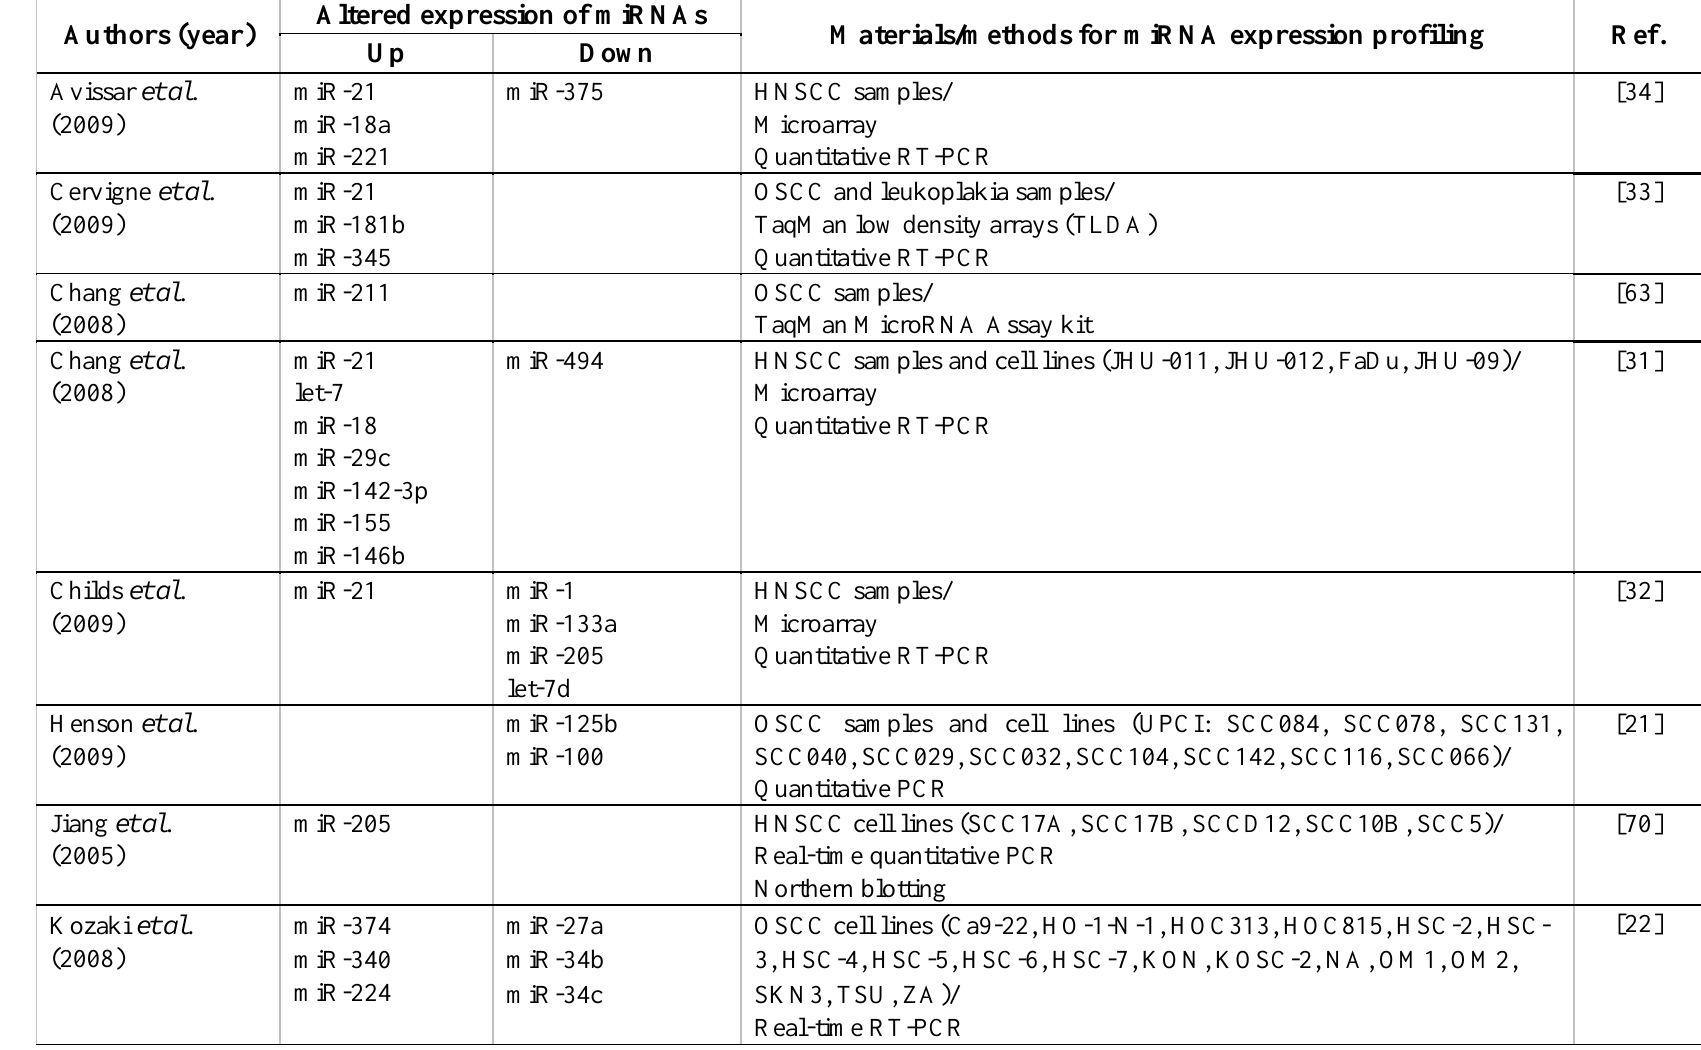
Table 1. Expression profiling of miRNAs in